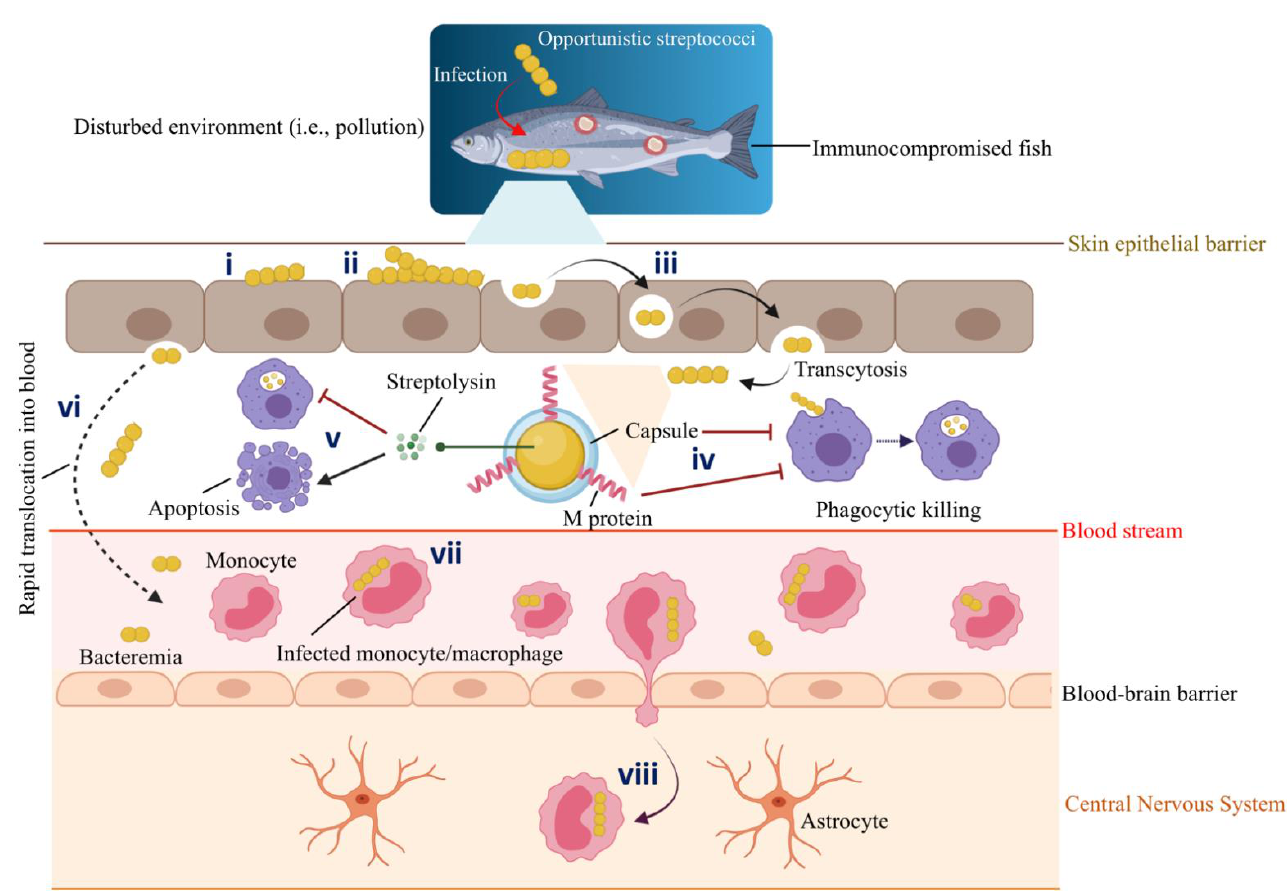
Figure 3. Schematic representation of host-pathogen interactions between marine fish and opportunistic Streptococcus spp . Gram- positive streptococci infect immunocompromised fish with a decreased immune response that lives in a conducive environment (e.g., polluted marine environment) that facilitates such an infection: ( i ) Adhesion. ( ii ) Colonization of the epithelial barrier (i.e., mucus). ( iii ) Epithelial invasion by transcytosis. ( iv ) Antiphagocytic factors such as capsule and M protein aid S. iniae to survive phagocytic killing. ( v ) Streptolysins secreted by S. iniae inhibit phagocytic killing and, at the same time, induce the apoptosis of phagocytes. Thus, infected macrophages undergo apoptotic death and fail to prime a specific immune response. ( vi ) Invasive streptococci persist intracellularly for a short time and rapidly translocate into the blood circulation system. ( vii ) S. iniae hijack the migrating monocytes or macrophages. For instance, Zlotkin et al. (2003) [57] observed the presence of 70% of the S. iniae in the infected monocytes in the blood of diseased fish. ( viii ) Infected monocytes/macrophages act as trojan horses that carry S. iniae , cross the blood-brain barrier, transmigrate, and deliver bacteria to the fish central nervous system (CNS). Thus, S. iniae can enter the CNS through its association with the migrating monocytes. This original illustration was generated by authors using BioRender (https://biorender.com/) (ac- cessed on 3 March